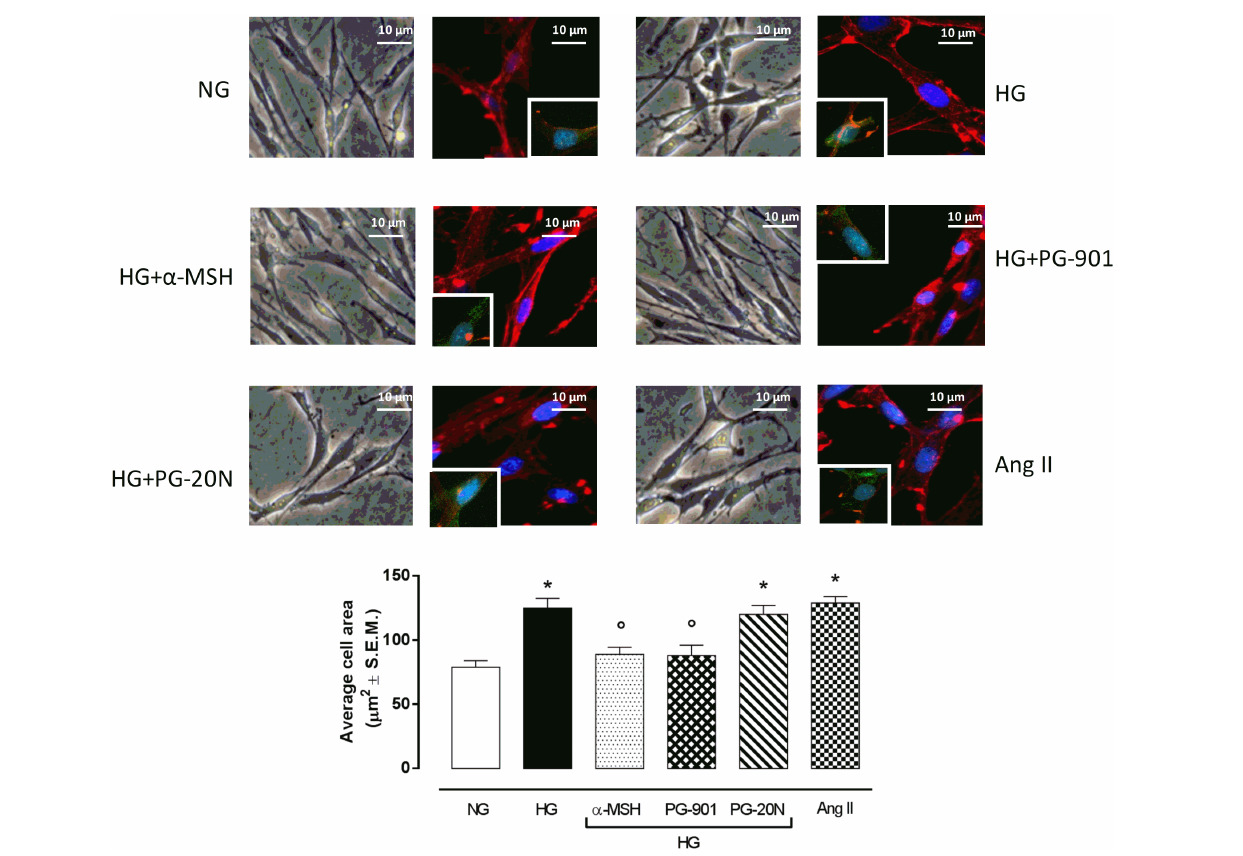
FIGURE 2 | Cell size visualization and quantization. Representative optic microscope (40X) and immunofluorescence images (40X; in blue Hoechst for nucleus and in red actin for cytoskeleton labeling) show that H9c2 cells exposed to high glucose (33 mM D -glucose) exhibited an evident increase in cell area compared to cells exposed to normal glucose (5.5 mM D -glucose). MC5R agonism with α -MSH (90 pM) and PG-901 (10 − 10 M) treatment significantly decreased cell area in H9c2 cells exposed to high glucose. Conversely, H9c2 cells treated with MC5R antagonist PG-20N and exposed to high glucose showed a cell area similar to HG cells. Also representative images of cell nucleus (blue), actin (red), and urotensin II receptor (anti-GPR14, green) co-localization are shown, evidencing that the increased cell area in H9c2 cells exposed to high glucose is paralleled by a high Urotensin II receptor labeling. This is decreased by α -MSH (90 pM) and PG-901 (10 − 10 M) treatments. Cell area was calculating by analyzing 300 cells in four different microscope fields. Values are expressed as mean ± S.E.M. of n = 9 values, obtained from the triplicates of three independent experiments. NG, normal glucose; Ang II, angiotensin II; HG, high glucose; ∗ P < 0,01 vs. NG; ◦ P < 0,01 vs.